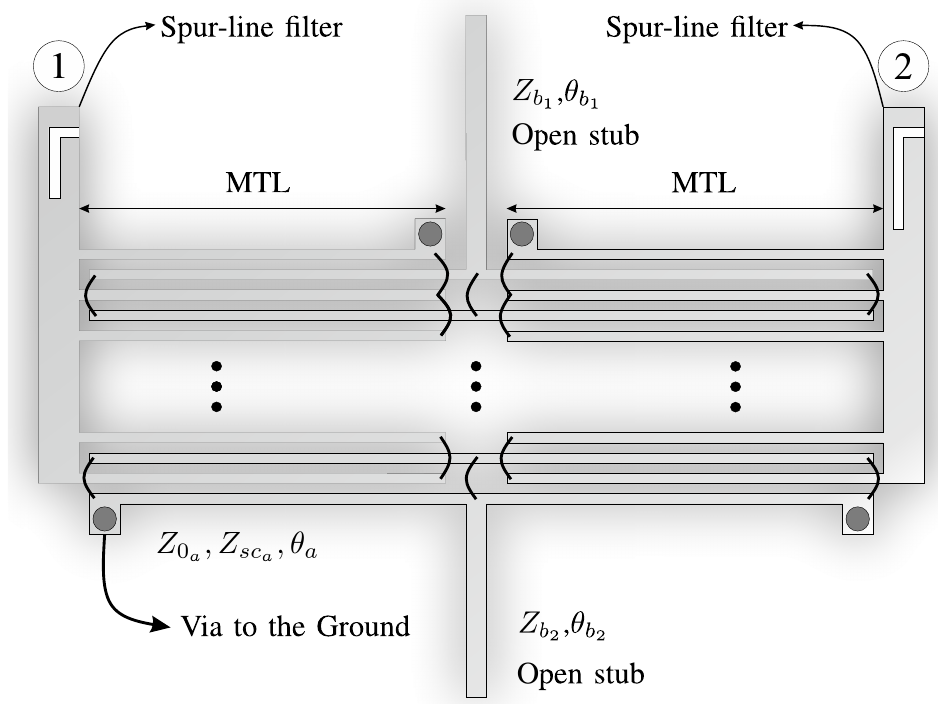
Figure 1. Layout of the proposed circuit for the analyzed multiband bandpass